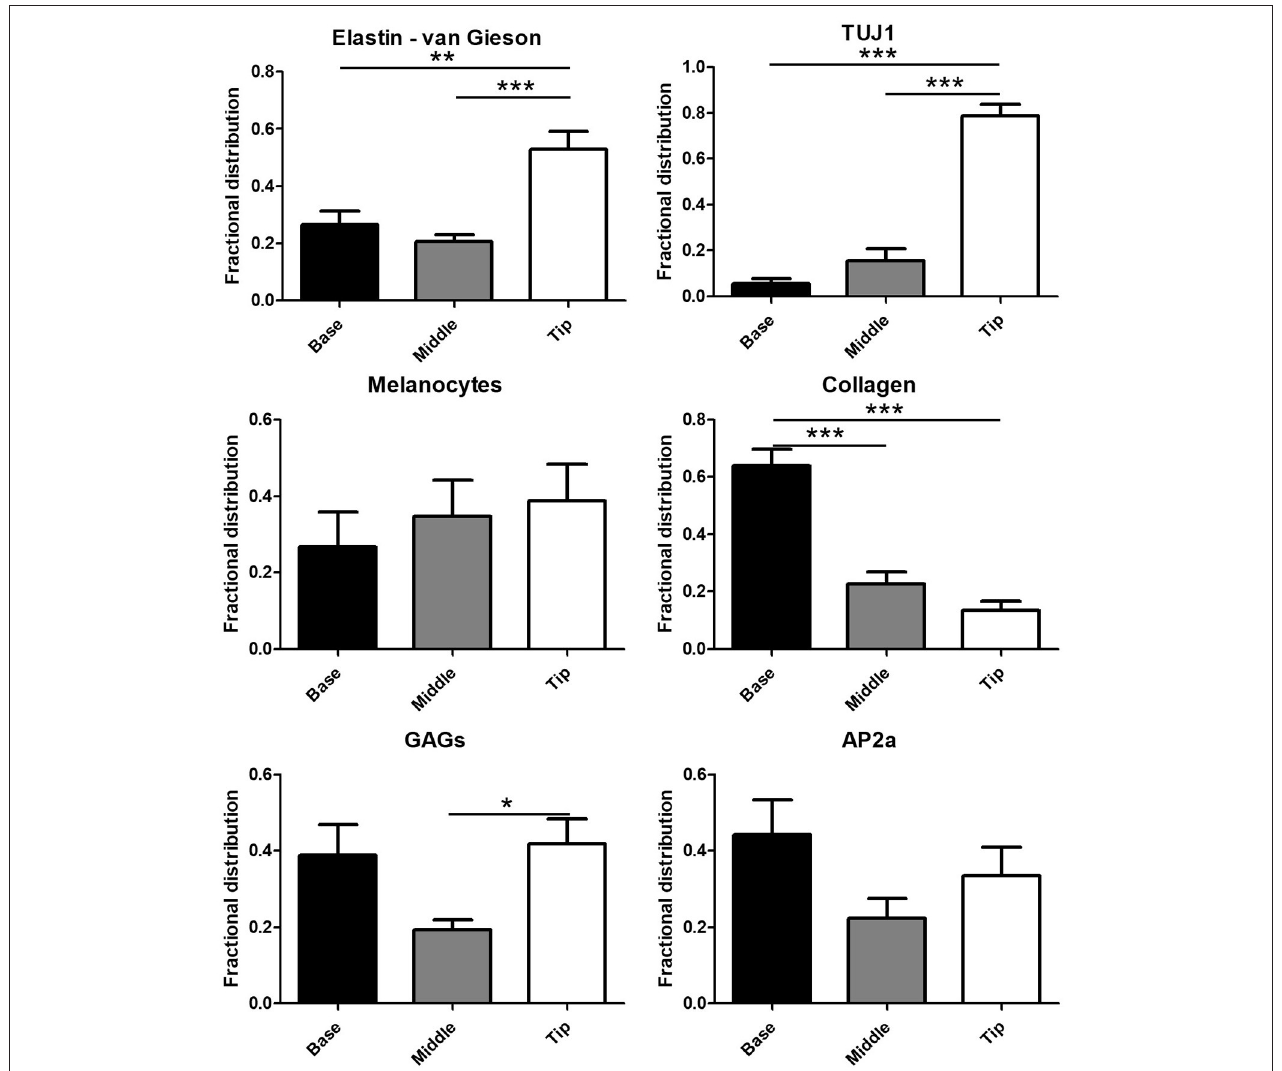
FIGURE 2 | Quantification of the glial transcription factor AP-2 α , Tuj1, collagen, glycosaminoglycans (GAGs), elastin, and melanin in digitally segmented leaflet portions (data represent fractional distribution of left coronary, noncoronary, and right coronary leaflets of n = 3 wild-type mice). * p < 0.05, ** p < 0.01, *** p <